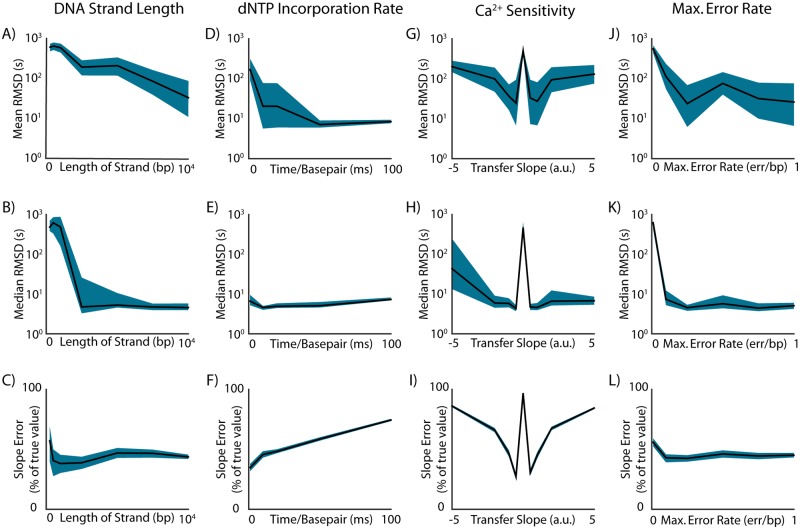
Effect of DNAP parameters on alignment and tuning estimation.Examining alignment performance using simulated DNAPs with varying parameters. Bootstrapped 95% confidence intervals of displayed values are indicated by blue silhouettes. A,B) The mean and median timing RMSD of alignments for DNA-based records of increasing length. C) Error in slope estimation for DNA-based records of increasing length. D,E) The mean and median timing RMSD of alignments for DNAPs with decreasing nucleotide incorporation rates. F) Error in slope estimation for DNAPs with decreasing nucleotide incorporation rates. G,H) Mean and median timing RMSD of alignments for DNAPs with increasing sensitivity to [Ca2+]. I) Error in slope estimation for DNAPs with increasing sensitivity to [Ca2+]. J,K) The mean and median timing RMSD of alignments for DNAPs of increasing maximum error rate. L) Error in slope estimation for DNAPs with increasing maximum error rate.